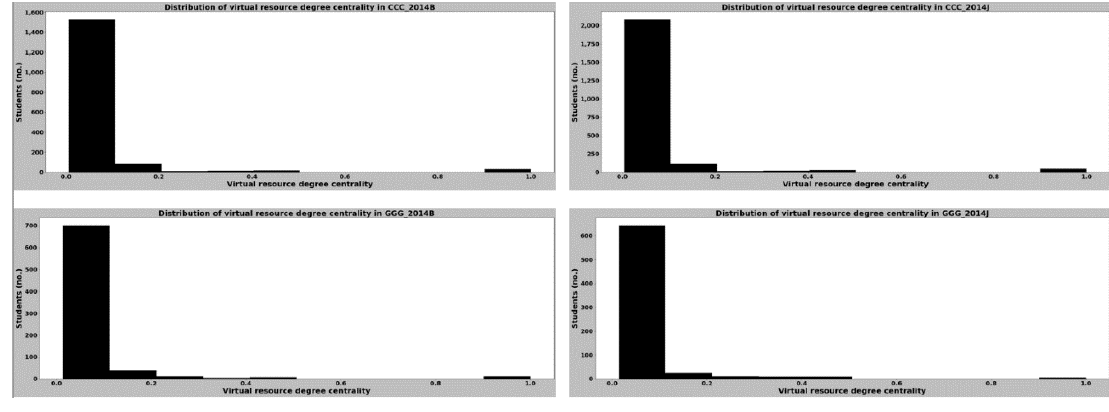
Figure 8 Distribution of Degree Centrality for Entire Learner Cohort in Courses CCC and GGG in 2014